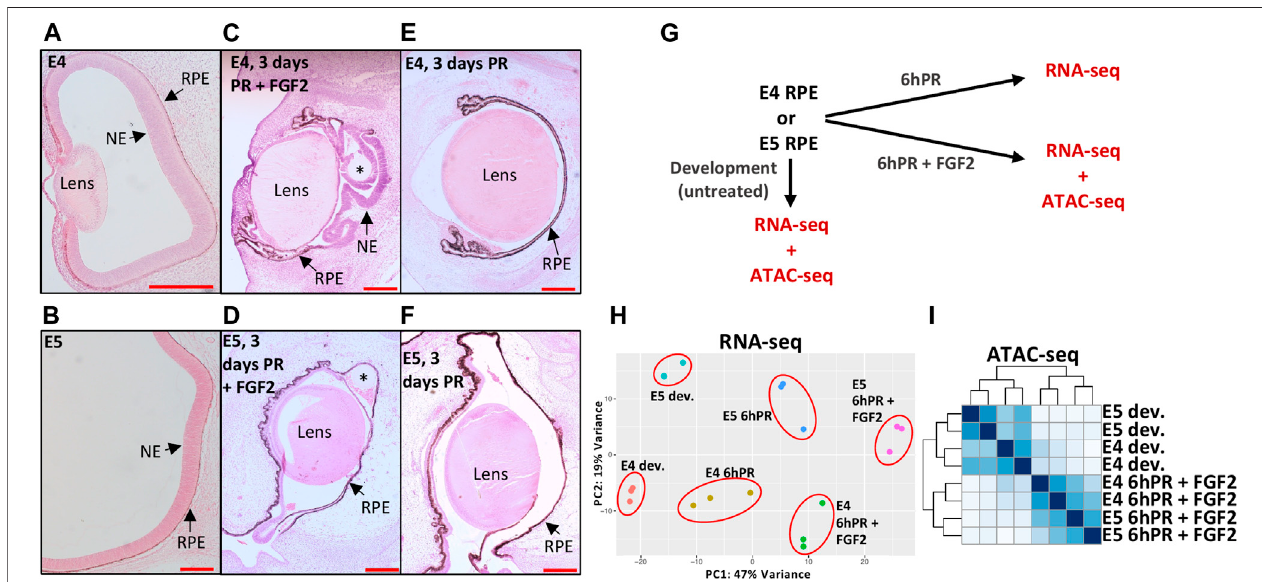
FIGURE 1 | Pro fi ling gene expression and genomic accessibility in the plastic and fate-restricted RPE. The developing (dev.) eye at E4 (A) and posterior eye at E5 (B) are shown with RPE and neuroepithelium (NE; presumptive neural retina) labeled. A regenerating NE isobserved 3 days PR if treated with FGF2 at E4 (C) , but no regenerationisobserved3 daysPRandFGF2treatmentatE5 (D) .At3 daysPR,noregenerationisobservedifsurgeryisperformedatE4 (E) orE5 (F) intheabsenceof FGF2. Scale bars in (A – F) are each 200 μ m. Asterisk (*) denotes the FGF2 bead. (G) Schematic summarizes the collection of RNA-seq and ATAC-seq samples used in this study. (H) Principal component analysis summarizes the variation present in RNA-seq normalized gene expression values across 18 samples and six tested conditions. (I) Heatmap displays blind hierarchical clustering of normalized ATAC-seq peak signal for each